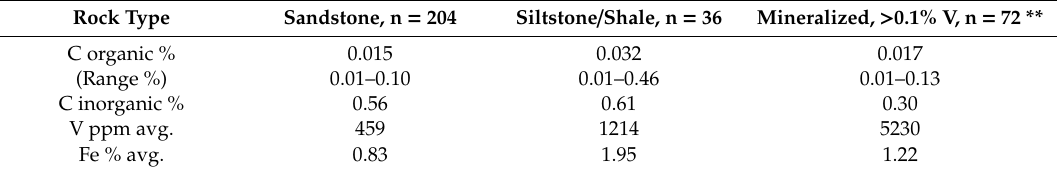
Table 2. Geometric mean * abundances and range of organic carbon contents in Bigrlyi samples. Rock